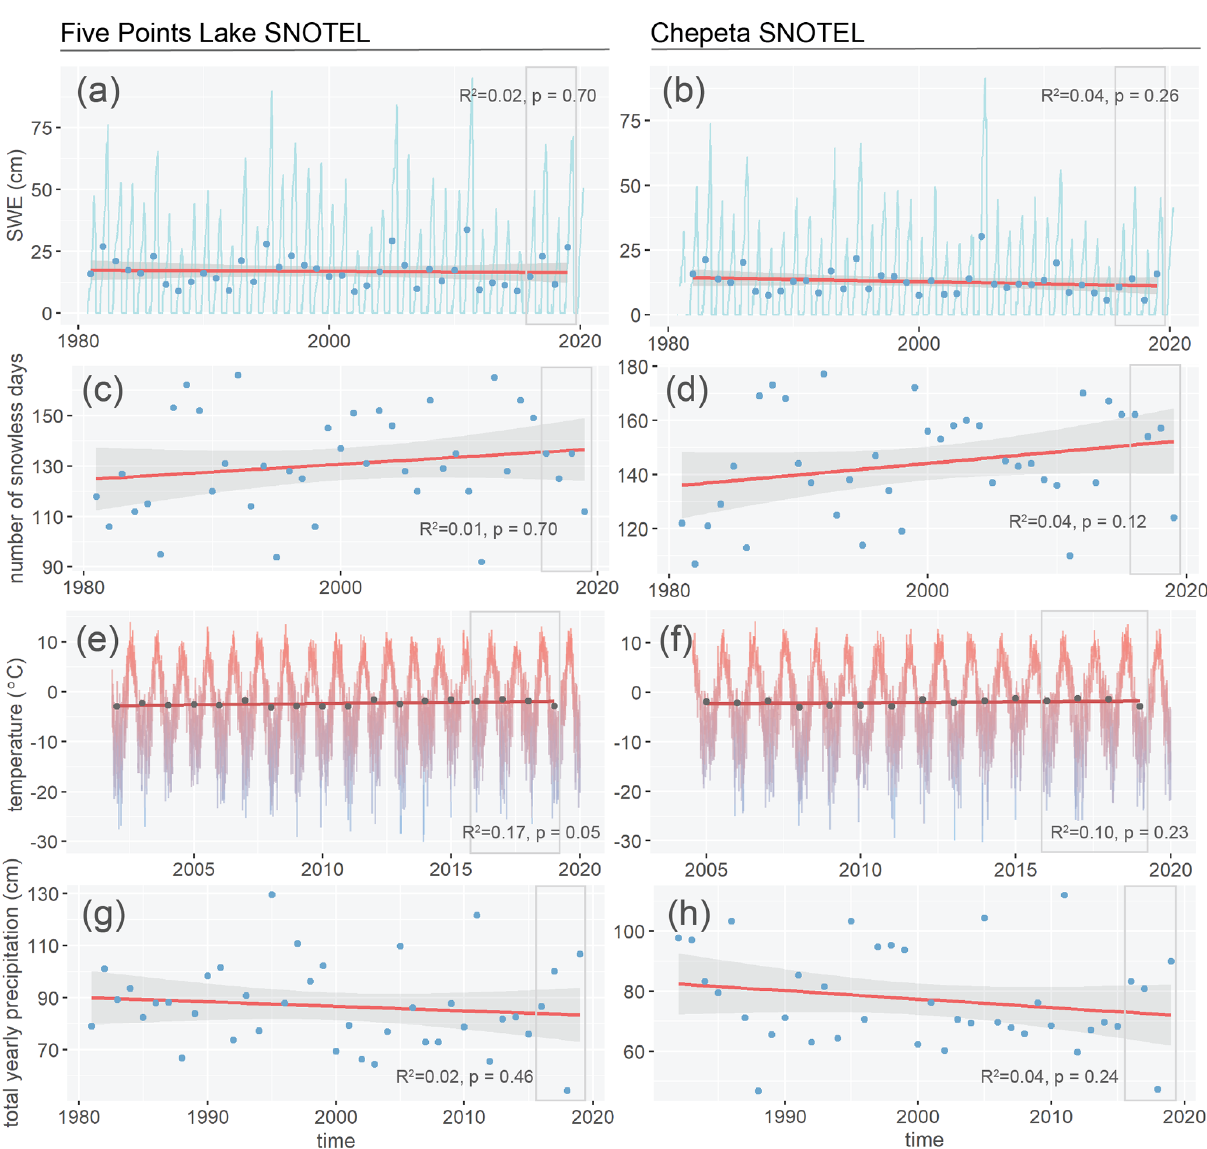
Figure 10. Climate over the past 40 years at the Five Points Lake SNOTEL (left) and Chepeta (right) SNOTEL stations. (a, b) Snow water equivalent (SWE). The light blue line is daily SWE. The dark blue points are mean annual SWE. (c, d) Number of days with no snow cover. Blue points represent number of days per year when SWE is 0. (e, f) Temperature over time. Blue to red regions represent daily temperature. Grey points are mean annual air temperature. (g, h) . Mean annual precipitation over time. Blue points represent mean annual precipitation. For all, red lines are linear trend lines, and gray regions around lines are 95% confidence intervals. Gray boxes represent the study